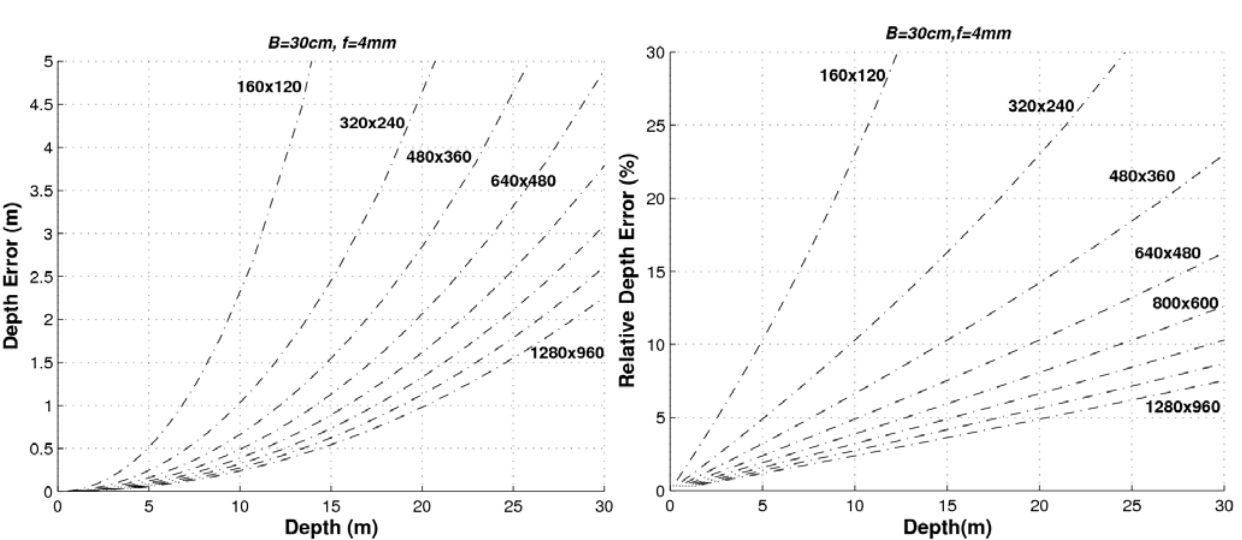
Figure 6. Absolute and relative depth estimation error for a stereo sensor